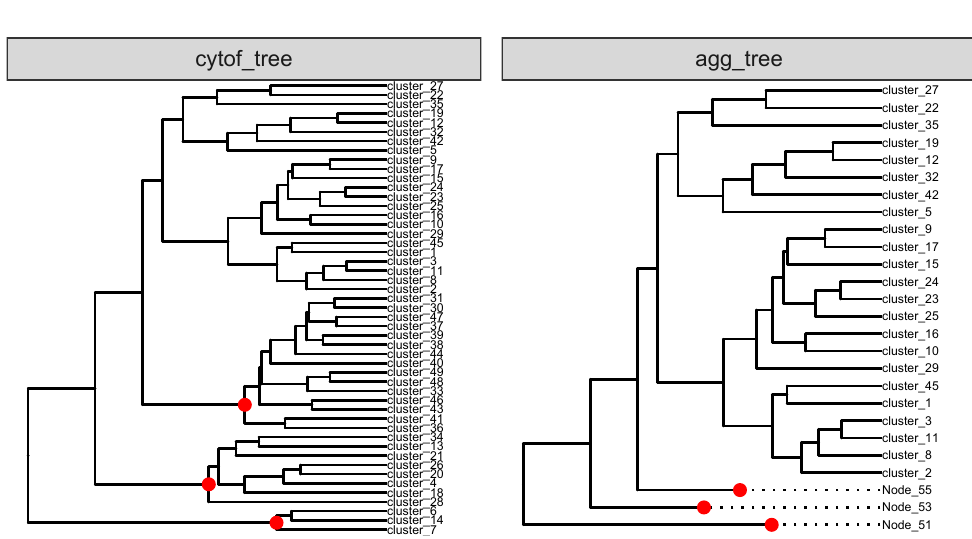
Figure 13. Comparison of two trees: cytof_tree and agg_tree . Three branches that are connected to the three red nodes in cytof_tree are merged, and are presented as dashed lines in agg_tree